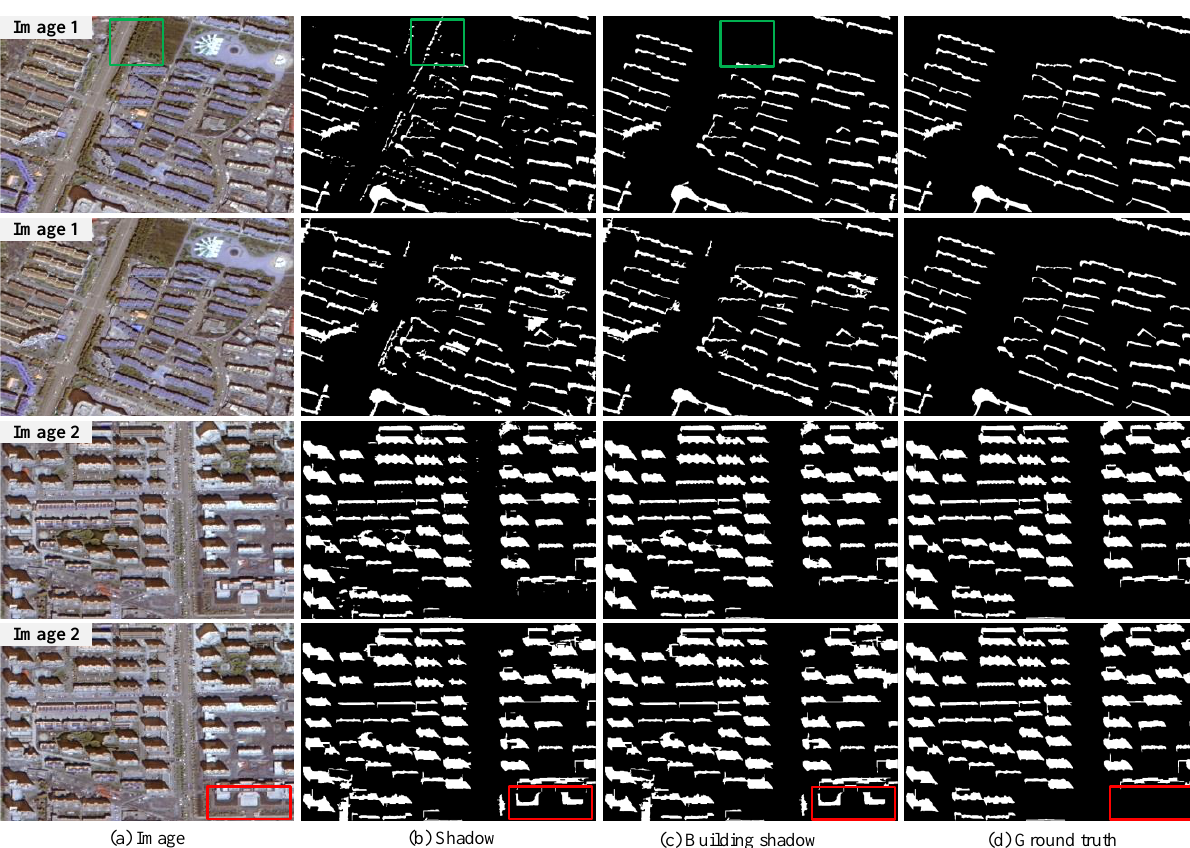
Figure 7. The shadow extraction results of two methods